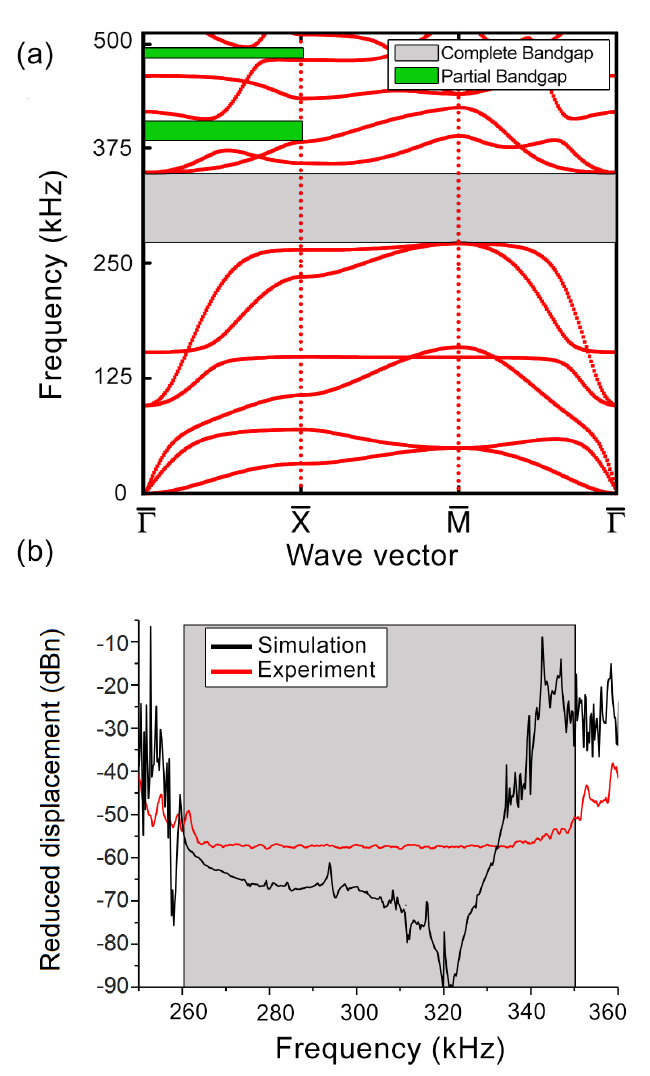
Figure 2. ( a ) Band diagram of unit cell ( b ) simulated (black) and experimental (red) transmission for the band gap between 260kHz to